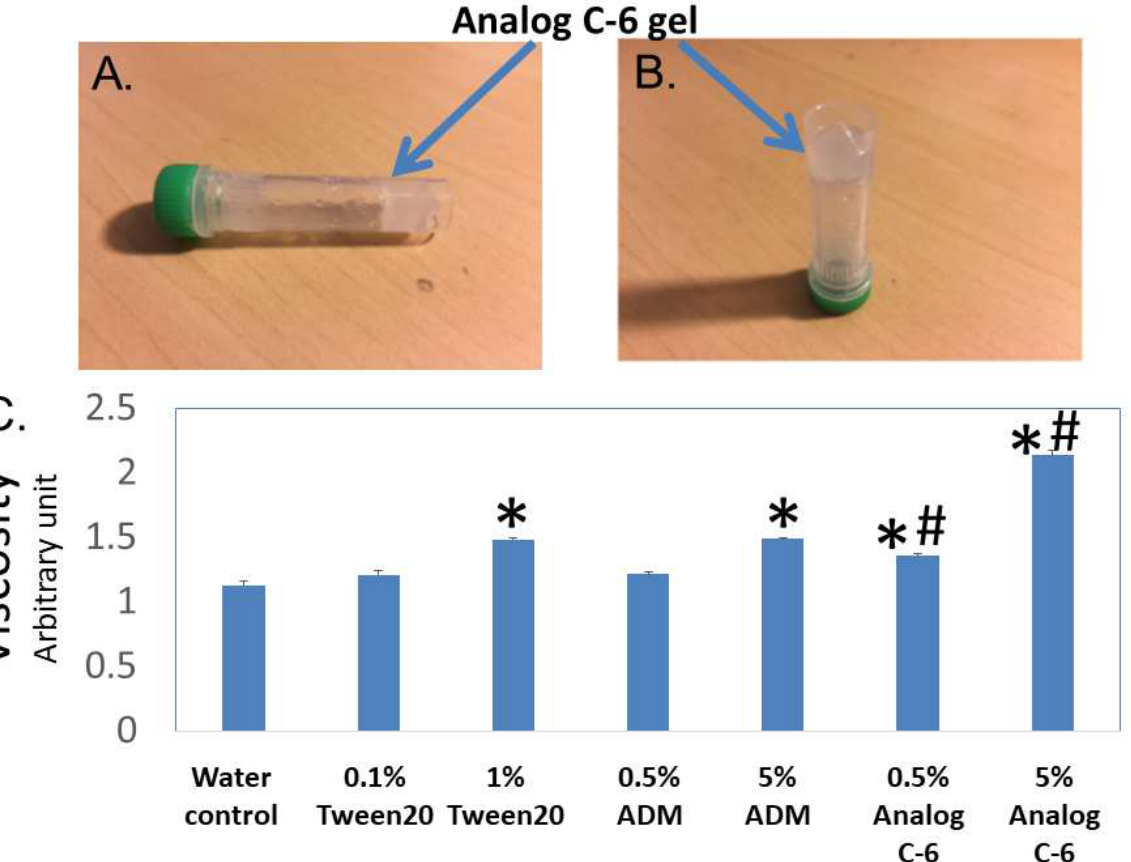
Figure 4. Analog C-6 self-assembles to form gels in situ, and the analog solution has a high viscosity . ( A , B ) Representative pictures of 11% Analog C-6 gel solution at 30 min after dissolution. The gel mass is indicated by blue arrows. ( C ) The relative viscosity of a 5% glucose solution (water solution), 1% Tween 20 solution, 0.5% and 5% wild-type ADM solutions in 5% glucose, and 0.5% and 5% Analog C-6 solutions in 5% glucose. The relative viscosity was measured by a